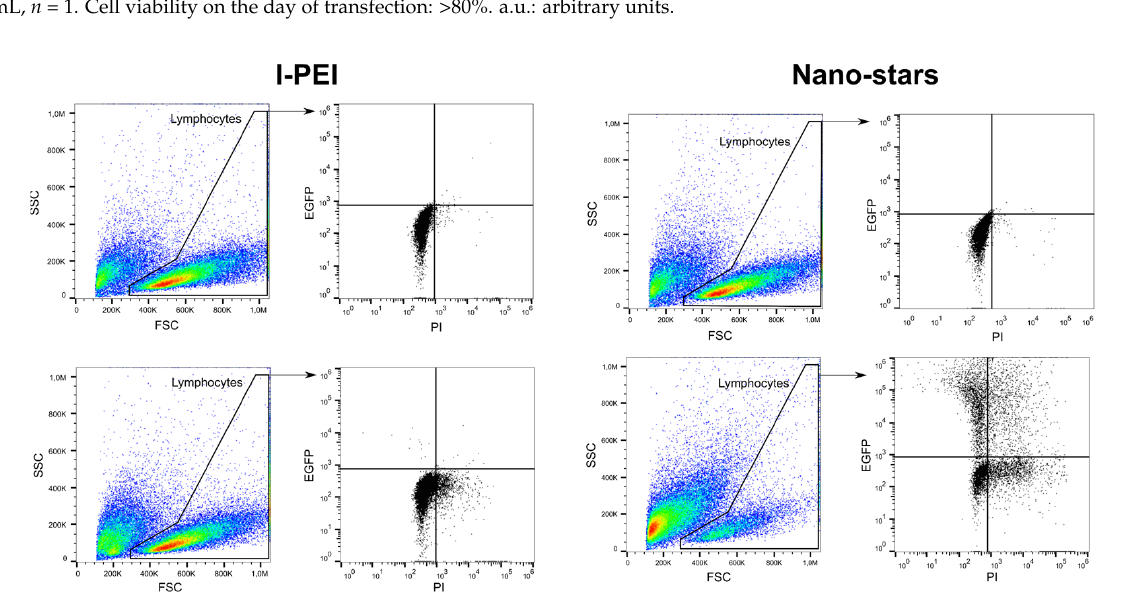
Figure 1. Representative gating strategy for flow cytometry analysis. Top: mock transfection, bottom: Cells transfected with l-PEI (left) and nano-stars (right).